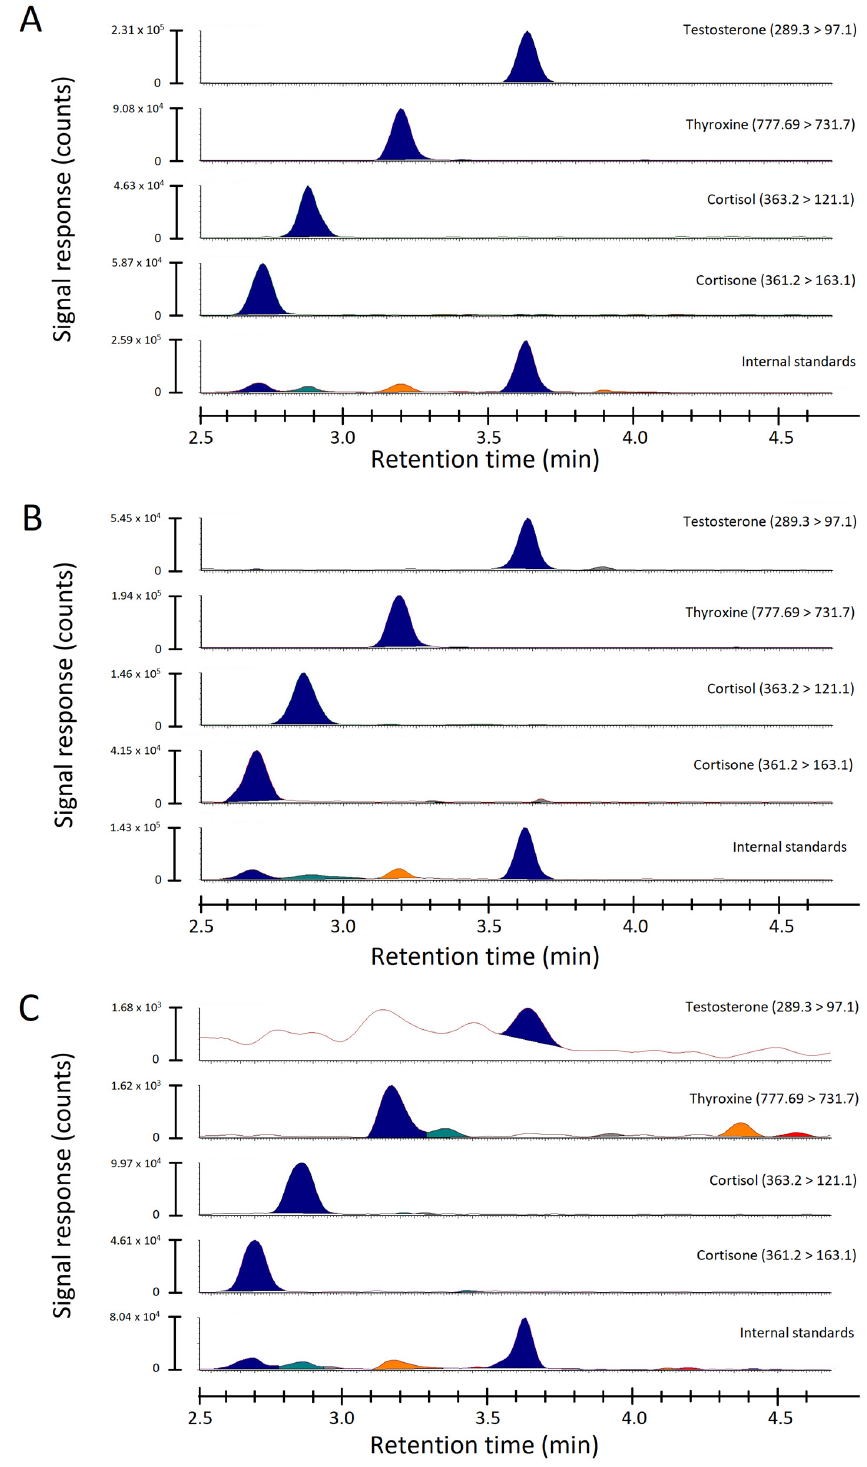
Figure 3. MRM-chromatograms in the order of top to bottom of testosterone, thyroxine, cortisol, cortisone, and isotopically labeled internal standards combined. ( A ) standard sample containing: 10.8 ng/mL testosterone, 25.0 ng/mL thyroxine, 12.0 ng/mL cortisol, and 11.5 ng/mL cortisone. ( B ) human serum containing: 5.1 ng/mL testosterone, 82.3 ng/mL thyroxine, 83.0 ng/mL cortisol, and 14.5 ng/mL cortisone. ( C ) fish plasma containing: 0.2 ng/mL testosterone, 2.1 ng/mL thyroxine, 98.7 ng/mL cortisol, and 32.9 ng/mL cortisone.